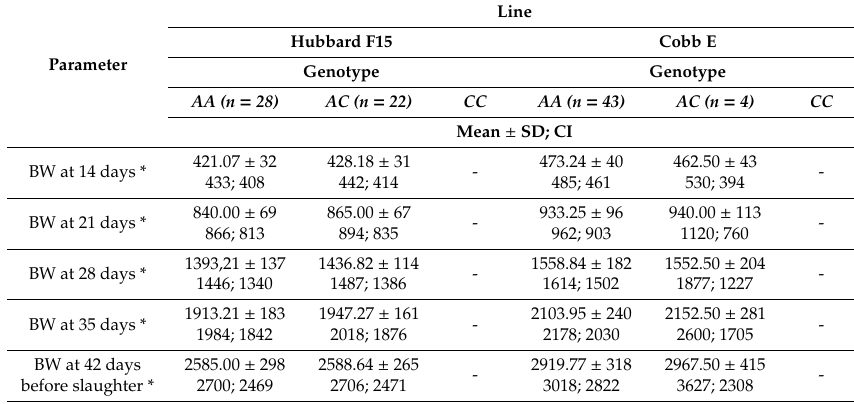
Table 5. The average growth performance and carcass traits in the chicken population (according to IGF1